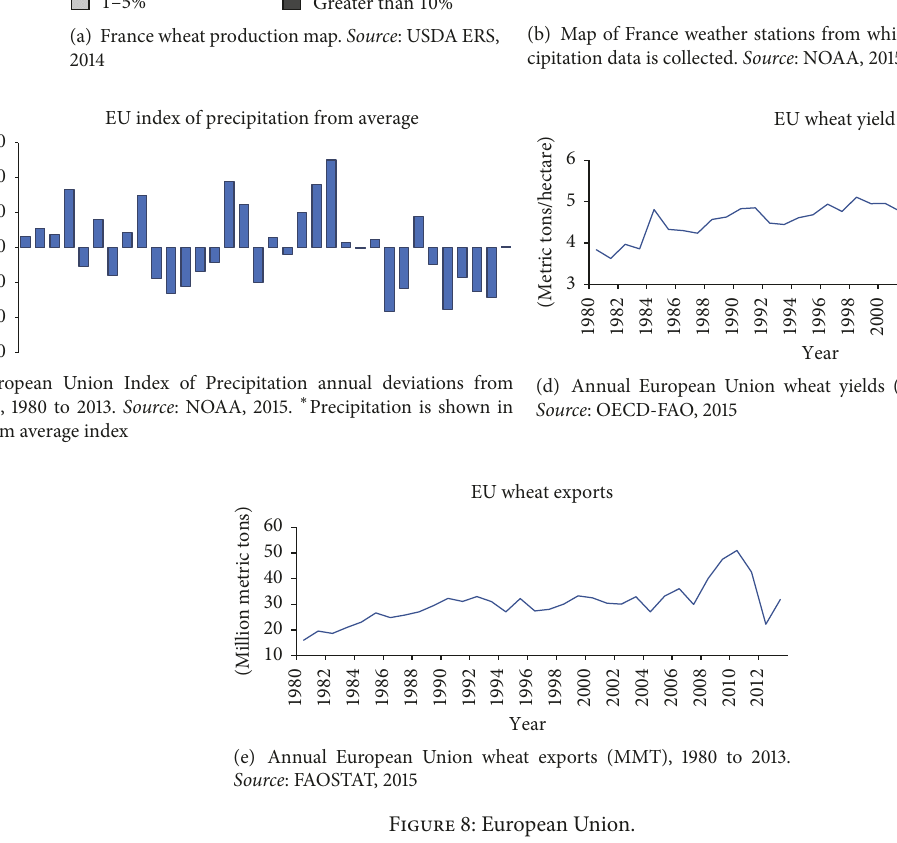
Figure 8: European